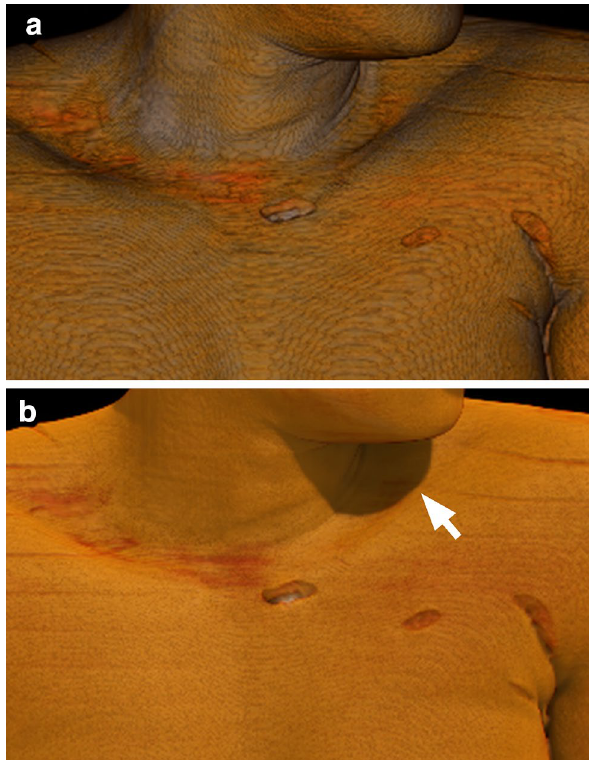
Figure 2. A 36 year-old woman killed by multiple stabs with a knife. (( a ) 3D CT VR image, ( b ) 3D CT GIR image). ( a ) 3D CT VR images showed remarkable striping reminiscent of contour lines on the skin surface. ( b